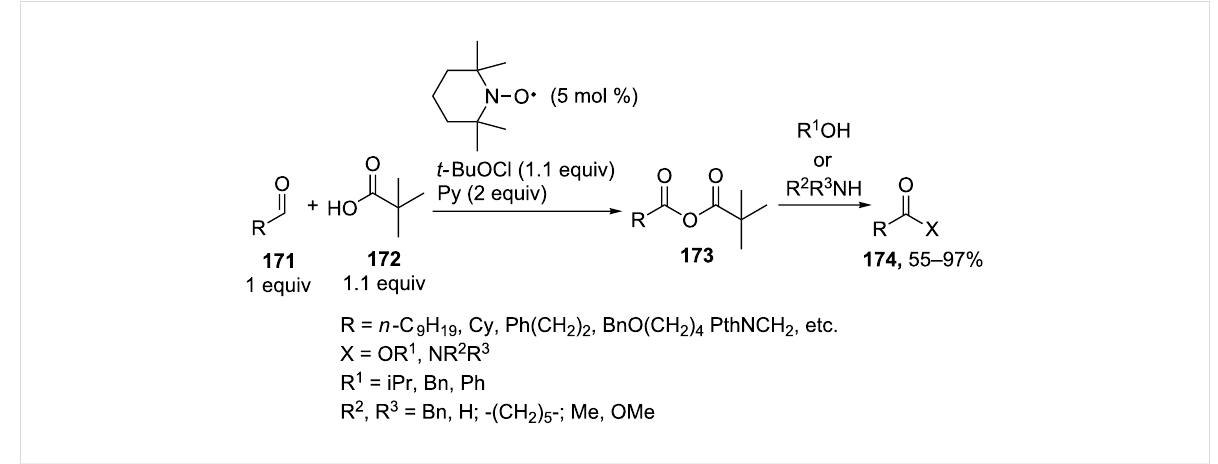
Scheme 35: Oxidative coupling of aldehydes with pivalic acid ( 172 ).